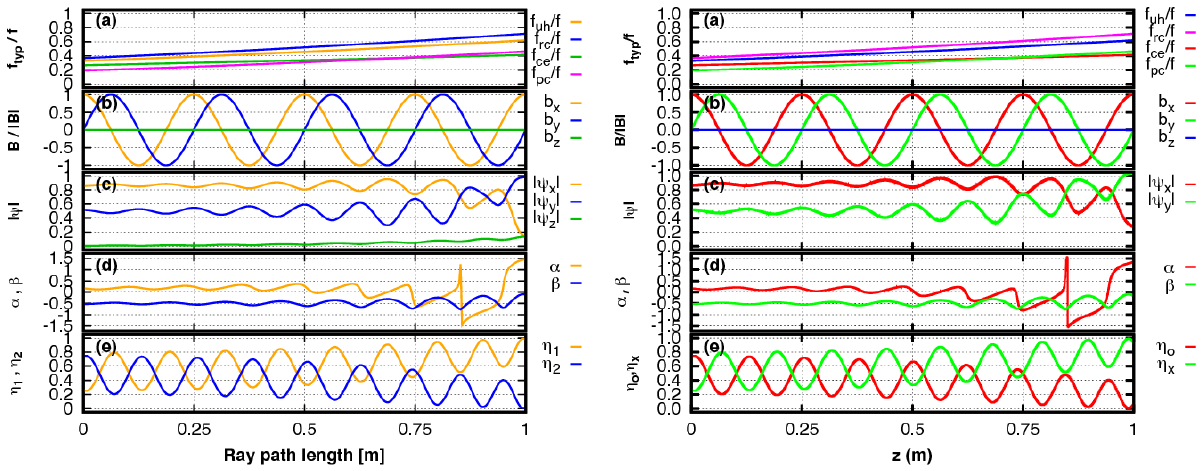
Figure 1. Calculation results of extended ray tracing in cold plasma slab with a magnetic field shear period (cid:28) s = 1000. Up- per hybrid resonance, right hand cuto ff , cyclotron resonance, and plasma cuto ff normalized frequencies (a), x , y , and z components of magnetic field unit vector (b), x , y , and z components of ampli- tude intensity (c), polarization state angle (cid:11) and (cid:12) (d), and power fraction of two modes (e) are shown as a function of ray path length.